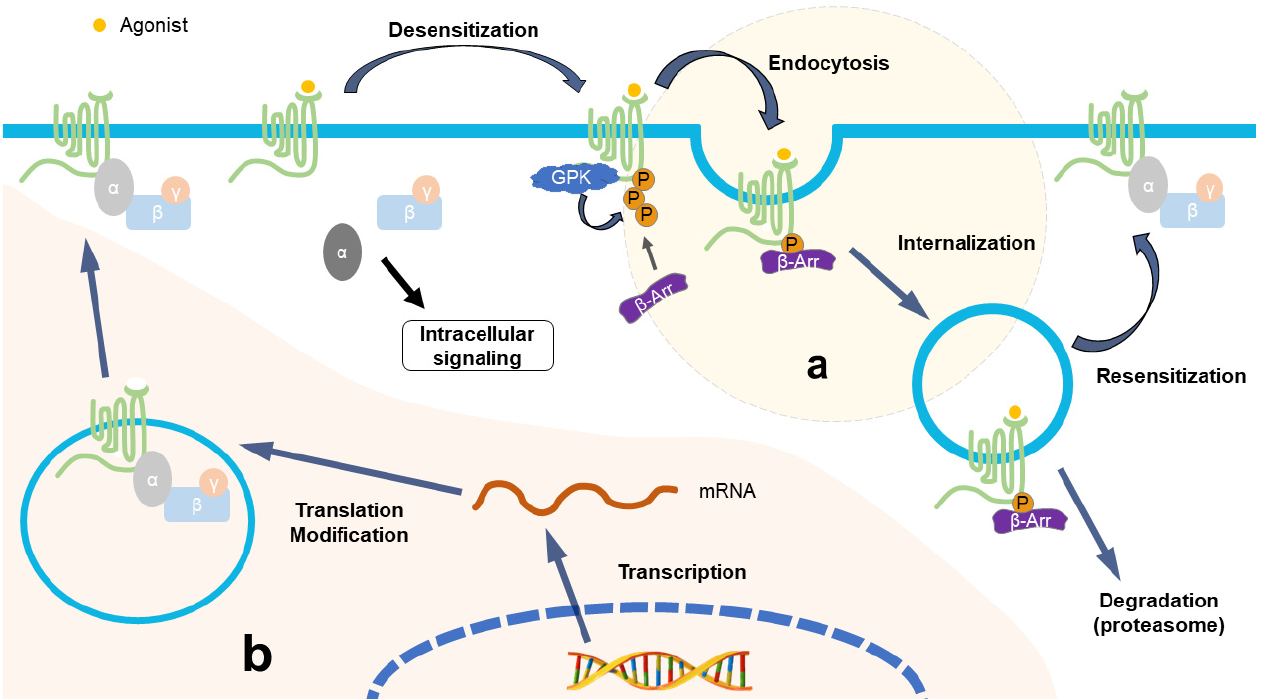
Figure 1. Identical consequences of NP and repeated opioid treatment from the perspective of opioid receptors. ( a ) Repeated use of opioid drugs promotes the imbalance of the desensitization–internalization–resensitization cycle of opioid receptors; for example, morphine cannot cause the internalization of MOR, leading to the accumulation of deactivated MOR on the cell membrane, resulting in the downregulation of opioid receptor function. The treatment of NP patients with opioids aggravates the downregulation of opioid receptors in the form of a vicious circle and aggravates the symptoms of opioid tolerance and hyperalgesia. ( b ) In the NP state, various factors a ff ect the synthesis of opioid receptors at the epigenetic level, transcriptional level, and post-transcriptional level, leading to a reduction in opioid receptors.